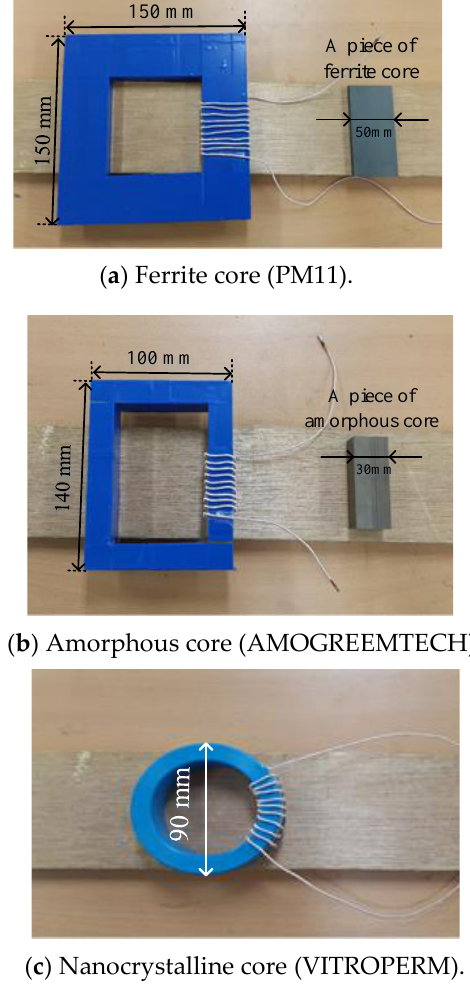
Figure 2. Experimental inductor model to identify complex permeability. Table 1. Physical dimensions for experimental verification.